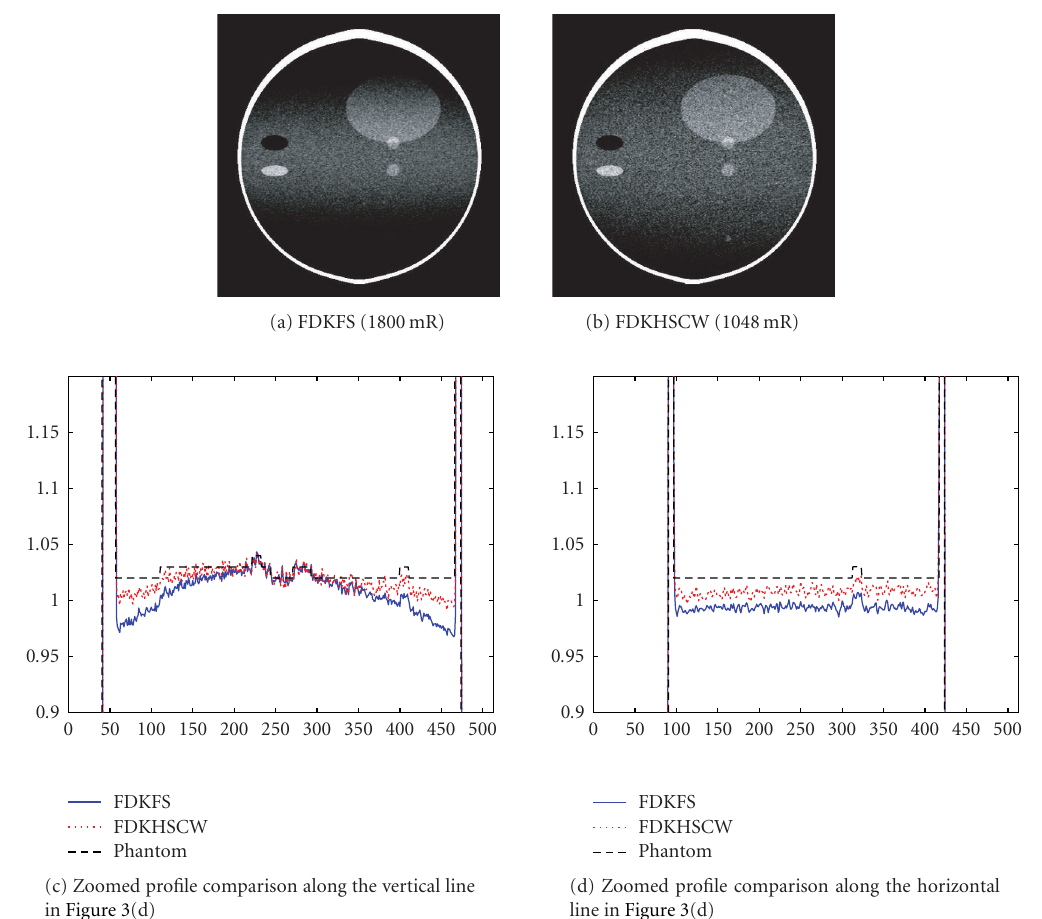
(c) Zoomed profile comparison along the vertical line in Figure 3(d) Figure 5: (a) FDKFS with total exposure level of 1800 mR. (b) FDKHSCW with total exposure level of 1048 mR. (c), (d) Profile comparison between FDKFS, FDKHSCW, and phantom along the solid vertical and horizontal lines in Figure